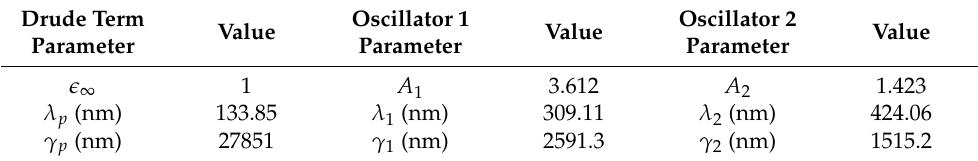
Table 1. Parameters for the Drude–Lorentz dispersion formula.